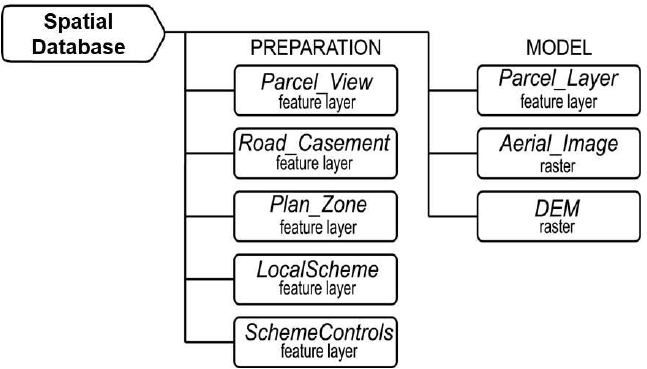
Figure 2. Proposed spatial database (geodatabase in this case) structure.